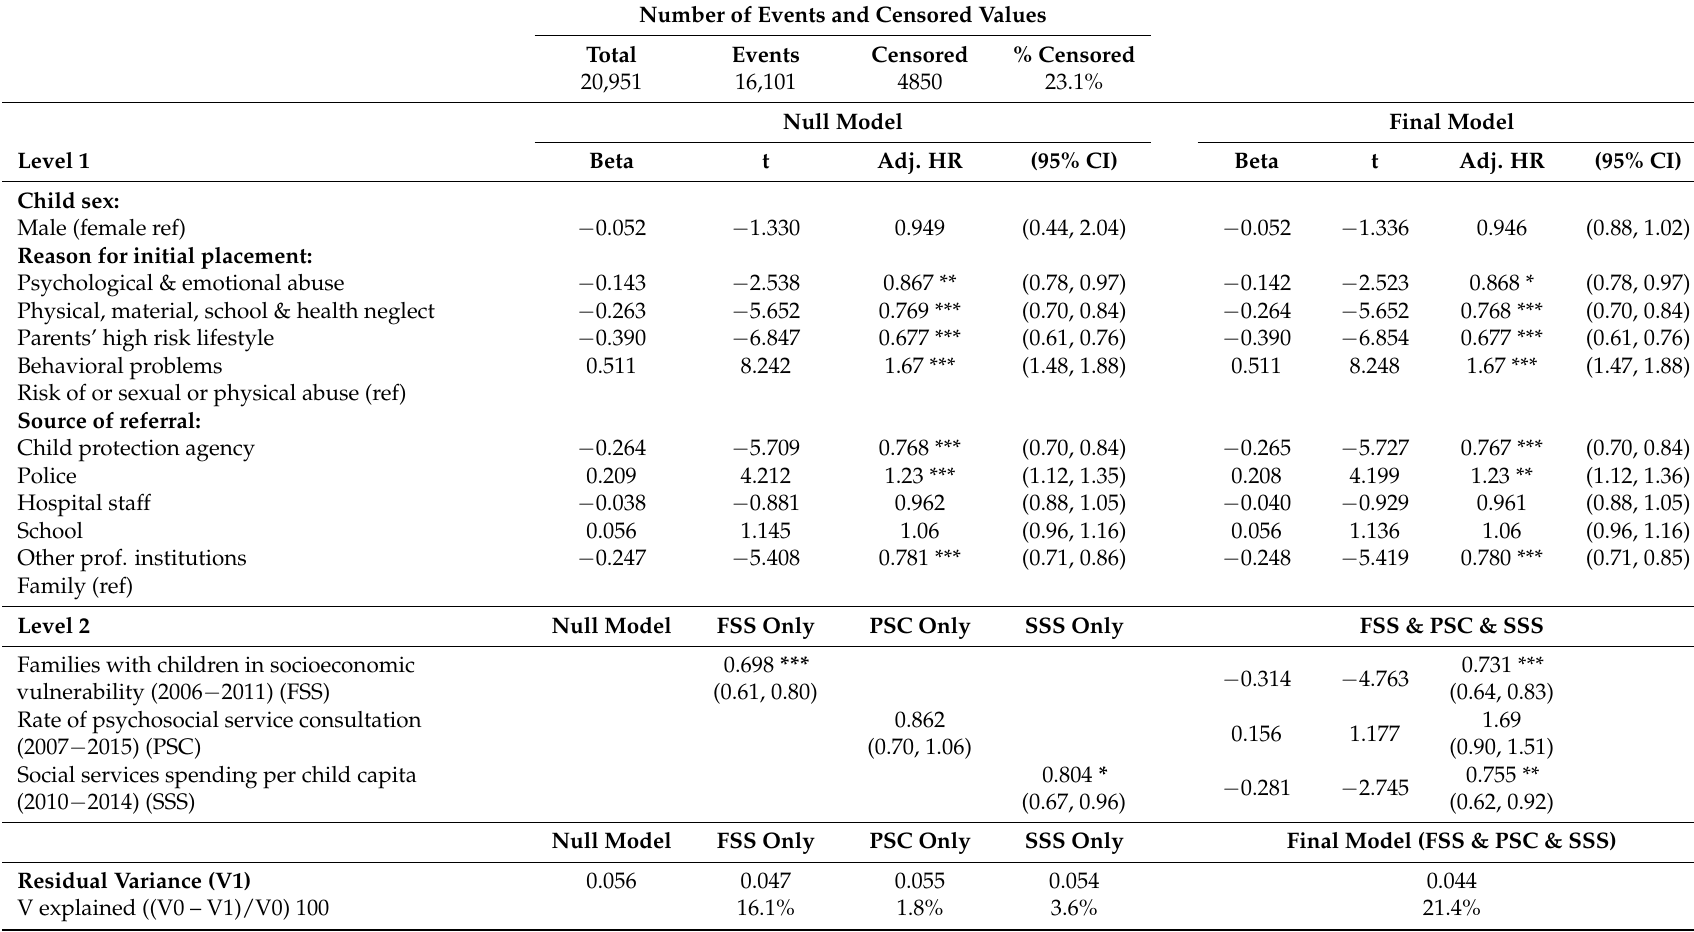
Table 5. Multilevel Cox proportional hazard model of family reunification for placed children age 12 to 17